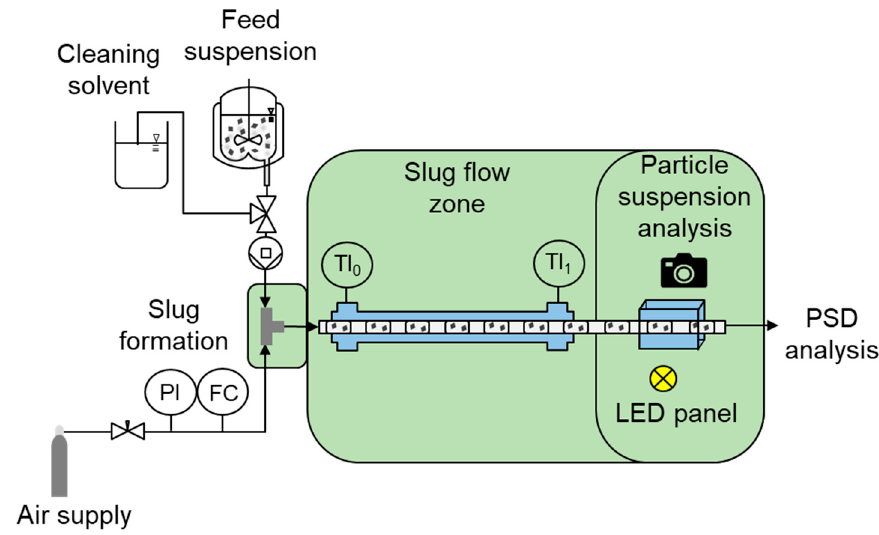
Figure 2. Schematic experimental setup of SFC.